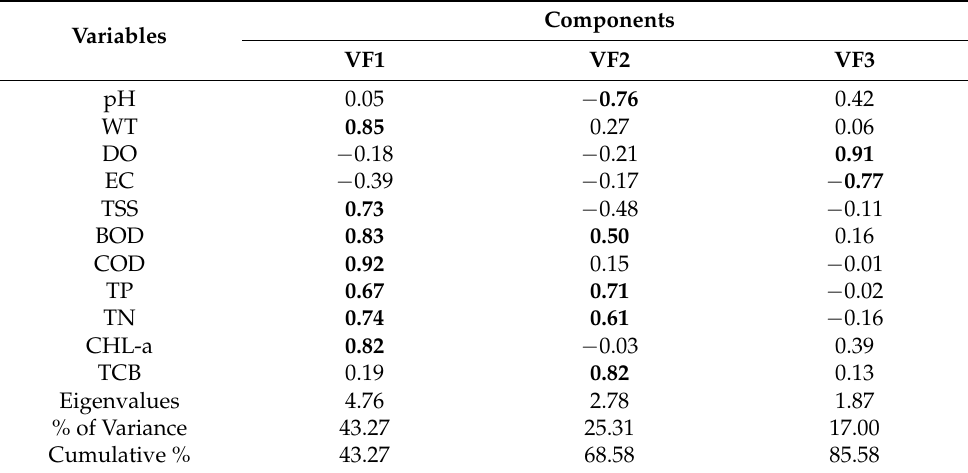
Extraction method: principal component analysis. Rotation method: varimax with Kaiser normalization. Bold values represent strong (>0.70) and moderate loadings (0.5–0.7), respectively. Note: pH: hydrogen ion concentra- tion; WT: water temperature; DO: dissolved oxygen; EC: electrical conductivity; TSS: total suspended solids; BOD: biological oxygen demand; COD: chemical oxygen demand; TP: total phosphorus; TN: total nitrogen;